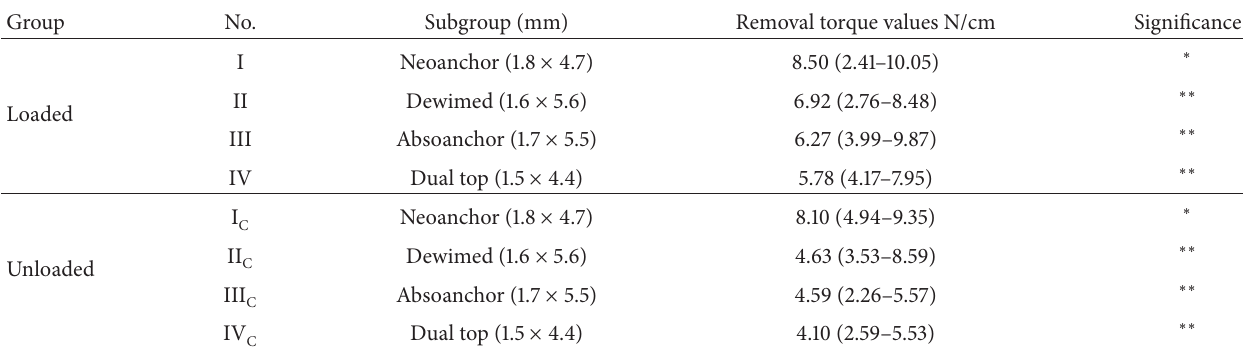
Table 2: Prescription and removal torque values of miniscrews for all groups.